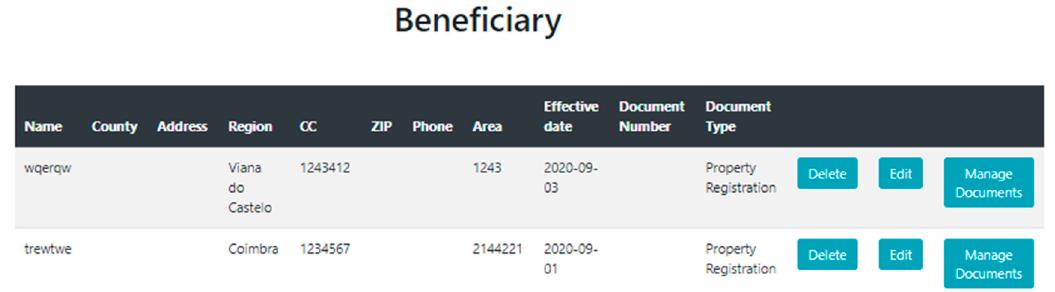
Figure 10. Beneficiaries of the property “Serpins” (ID = 498).